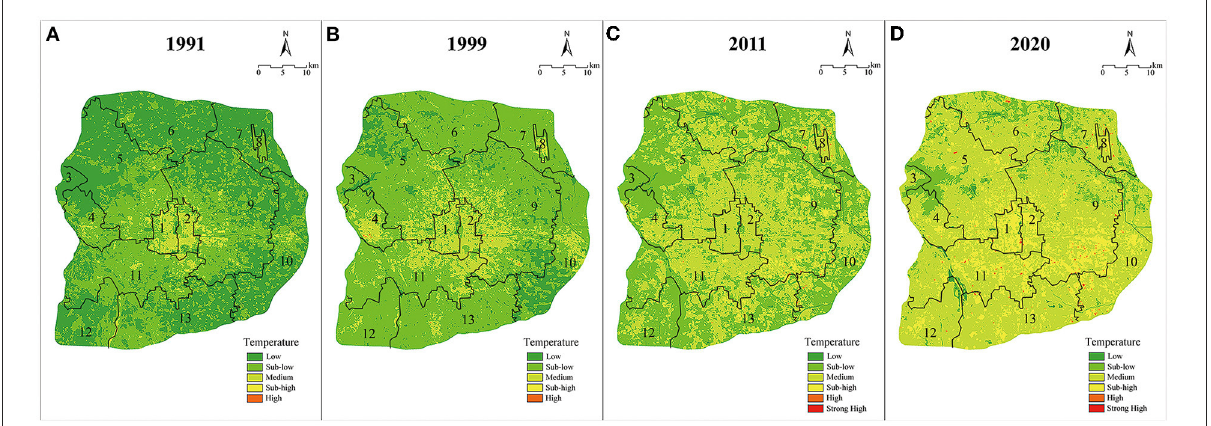
FIGURE7 Spatial and temporal distribution of temperature of 1991 (A) , 1999 (B) , 2011 (C) , 2020 (D) (1: Xicheng District ; 2: Dongcheng District ; 3: Mentougou District ; 4: Shijinshan District ; 5: Haidian District ; 6: Changping District ; 7: Shunyi District ; 8: Beijing Capital International Airport ; 9: Chaoyang District ; 10: Tongzhou District ; 11: Fengtai District ; 12: Fangshan District ; 13: Daxing